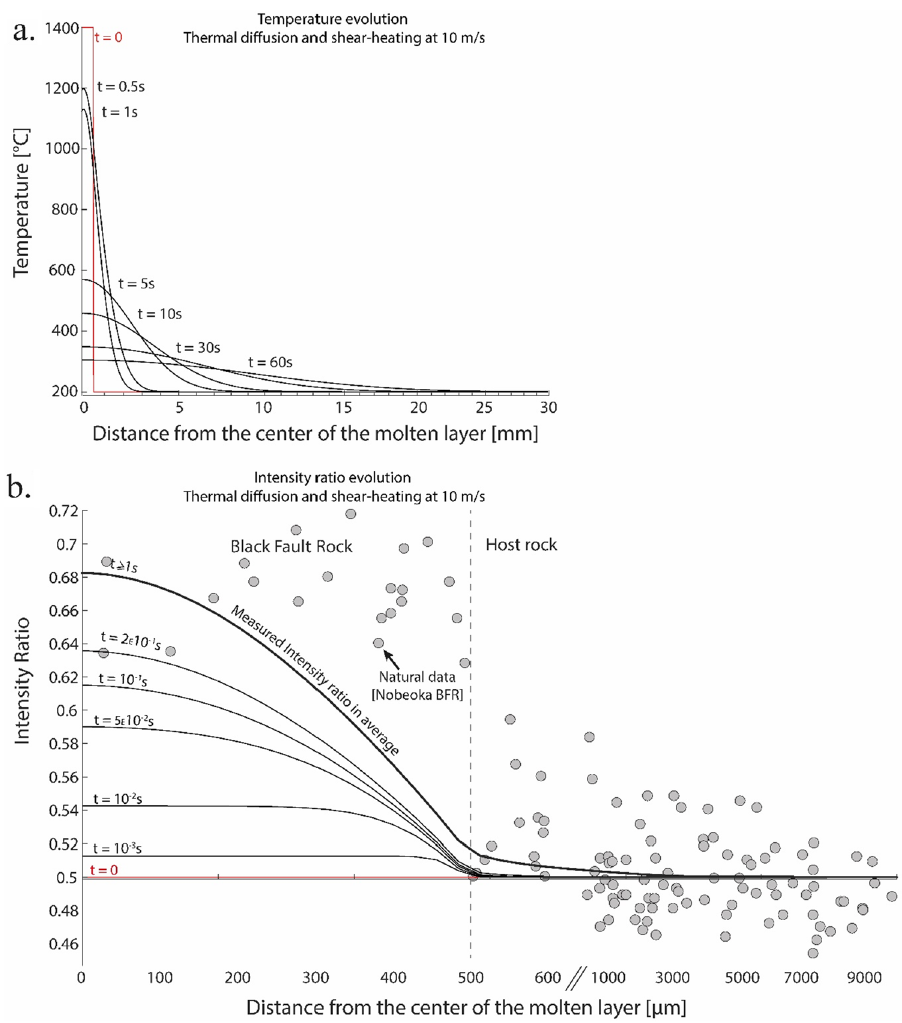
Figure 6. Thermal and kinetic modellings obtained for a 1 mm-thick molten layer where heat is transferred by diffusion to the host rock and is produced in the molten layer by viscous shear heating. ( a ) Temperature and ( b ) Intensity ratio evolution at different times (curves). Also presented, intensity ratio of the Nobeoka Black Fault Rock. Slip parameters (slip rate and total slip) were adjusted so that the modelled intensity ratio reaches the natural values at the center of the molten